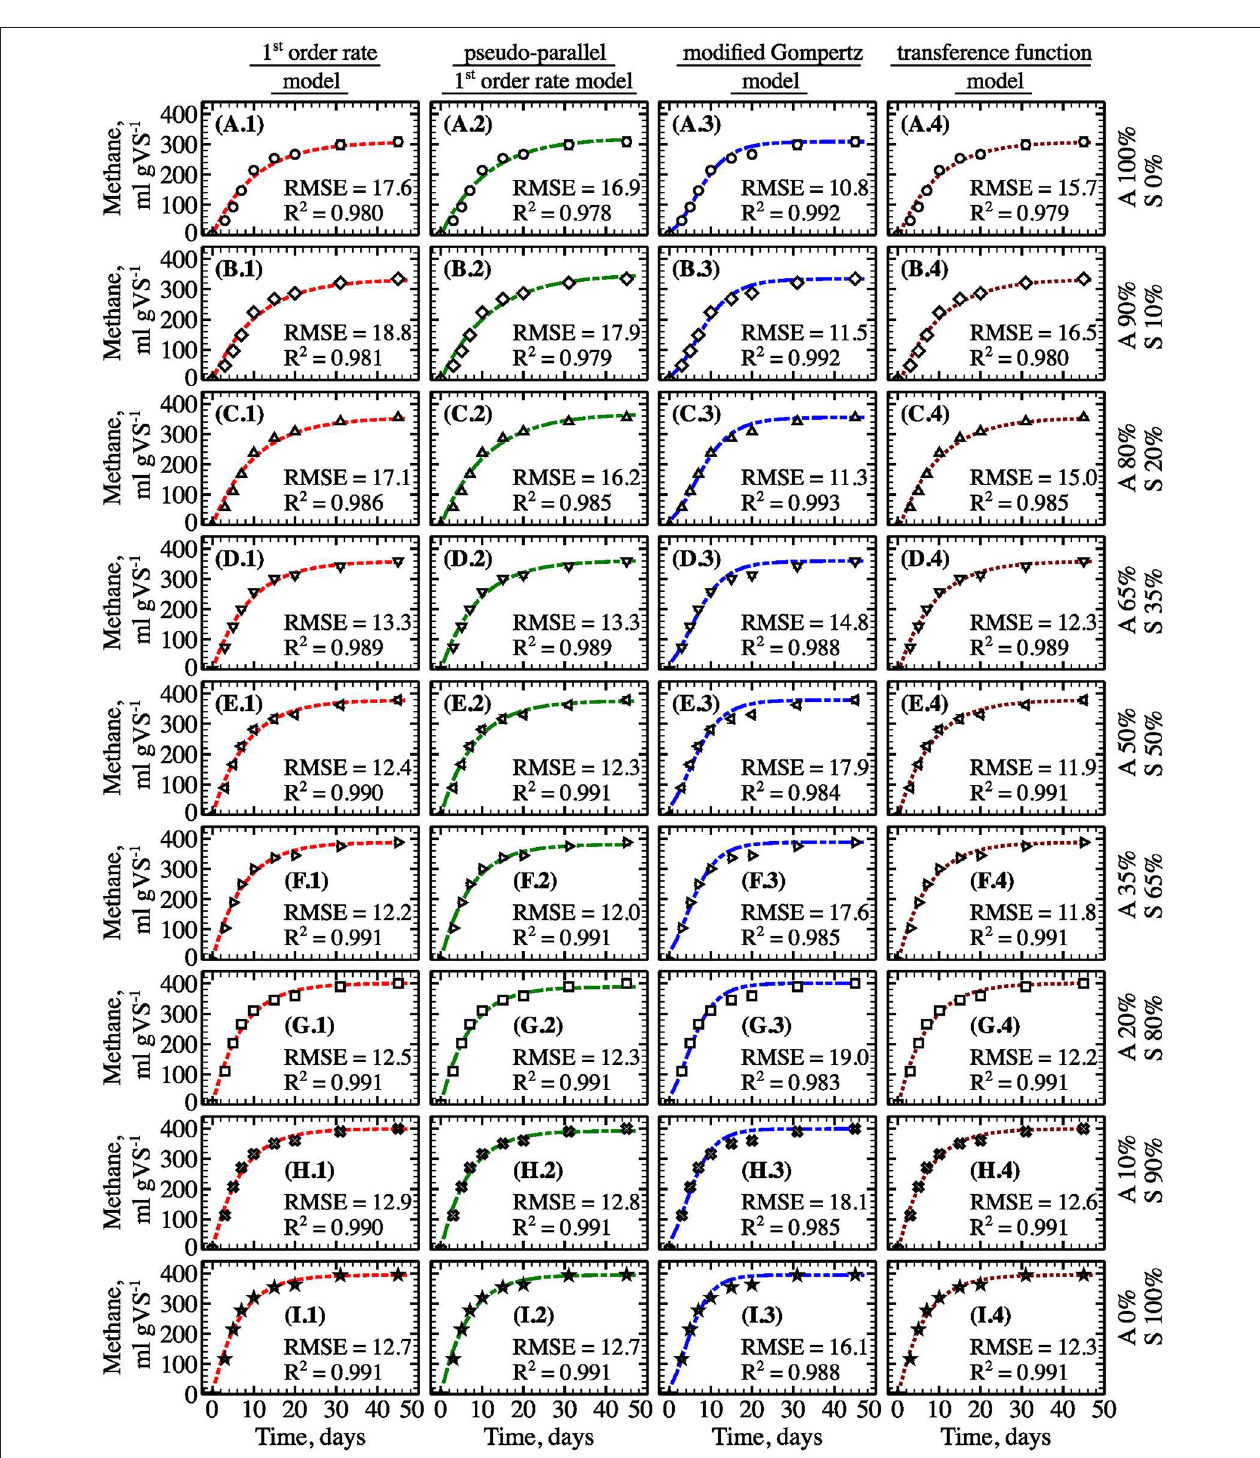
FIGURE 9 | Experimental and predicted specific methane yield from filamentous algal biomass as a single-substrate (A) , algae co-digested in different ratios with sewage sludge (B–H) and sewage sludge as a single-substrate (I) (points—experimental data; lines—model fit, type of the model is specified on top; algae (“A”) to sewage sludge (“S”) ratio are shown on the right; error bars represent 1 S.D. for three replicates).